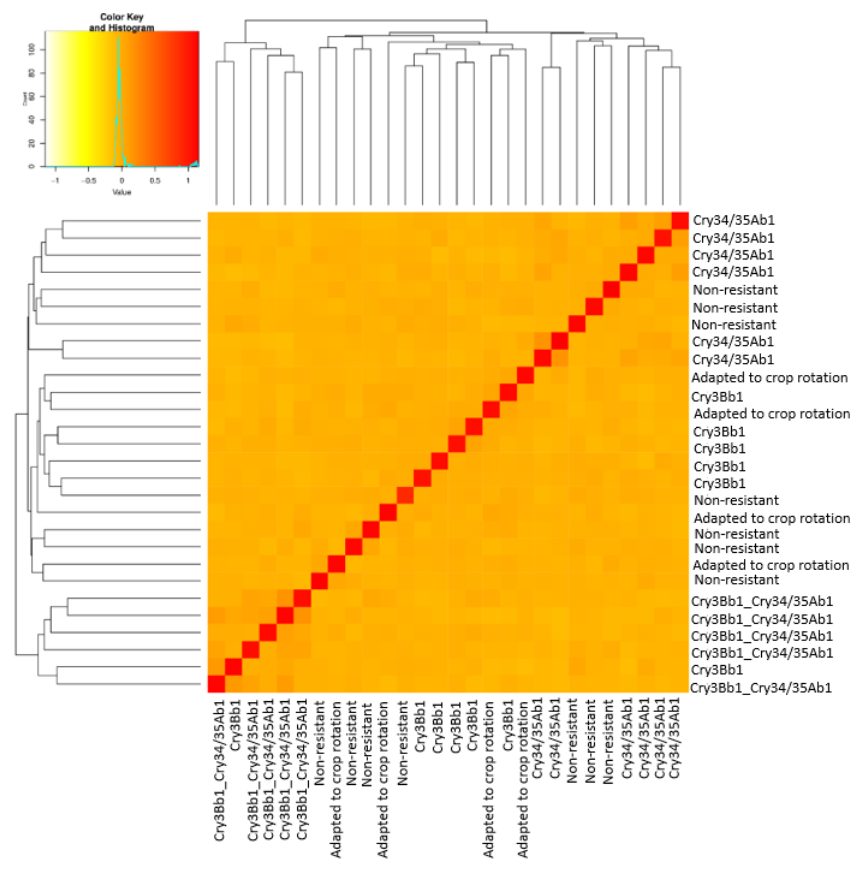
Figure 5. Heat map plot of kinship matrix using average linkage clustering based on SNP markers depicts the existence of three different groups among WCR genotype.